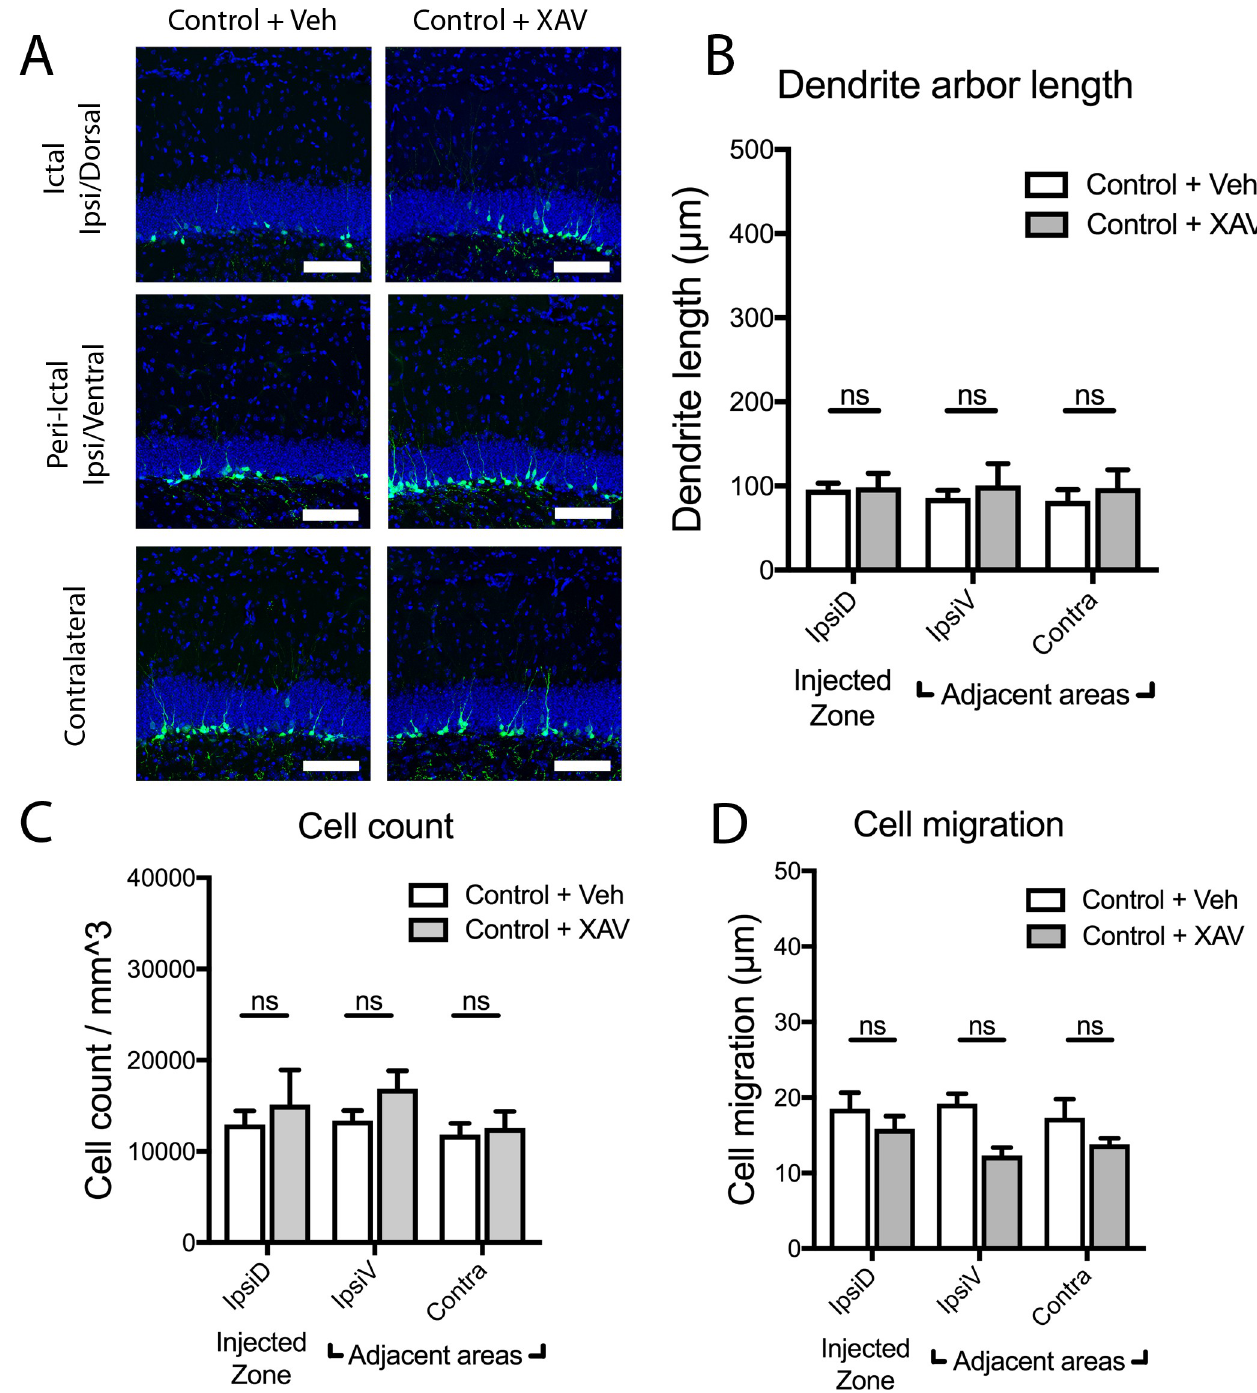
Fig 2. Treatment with novel Wnt antagonist XAV939 does not alter newborn dentate granule cell maturation in control animals. (A) Images demonstrate eGFP+ newborn dentate granule cells two weeks after intrahippocampal saline injection (control) in the ipsilateral dorsal, ipsilateral ventral, and contralateral dentate gyrus, of mice treated with vehicle vs. XAV939 daily for two weeks after injection. Scale bars 100 μ m. (B-D) In saline-injected control animals, continuous Wnt inhibition by XAV939 treatment does not alter newborn dentate granule cell arbor length (B), cell density (C), or cell migration (D), when compared with vehicle-treated control mice (ns = not